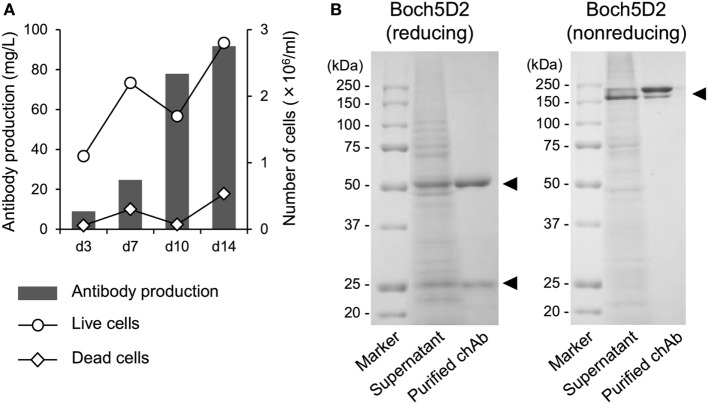
Production and purification of Boch5D2 in CHO DG44 cells. (A) Expression of Boch5D2. Boch5D2 was expressed stably in CHO DG44 cells in 30 ml of shaking culture. The numbers of live and dead cells (right axis: white circle and diamond) and antibody production (left axis: gray bar) were measured at 3- to 4-day intervals. (B) Purification of Boch5D2. Boch5D2 was purified from supernatants of shaking cultures. Purified protein was confirmed by reducing and non-reducing sodium dodecyl sulfate-polyacrylamide gel electrophoresis.